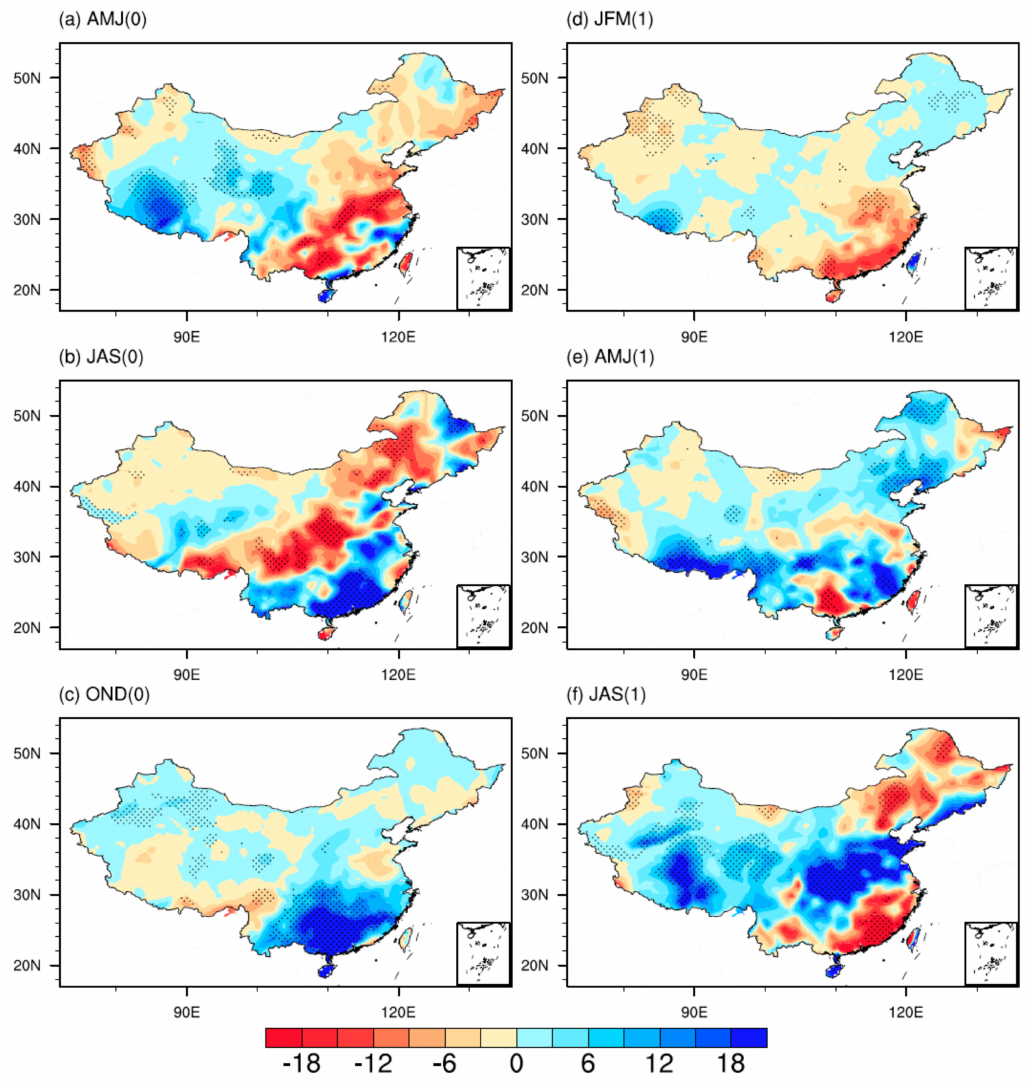
Figure 6. Partial regression coe ffi cients (mm / day per ◦ C) of the precipitation anomalies onto the DMI index, having removed the influence of ENSO during the period of 1950–2013. Shown are during ( a ) April to June (AMJ(0)), ( b ) July to September (JAS(0)), and ( c ) October to December (OND(0)) in the developing phase, and the following ( d ) January to March (JFM(1)), ( e ) April to June (AMJ(1)), and ( f ) July to September (JAS(1)). The stippling indicates statistically significant at the 90%